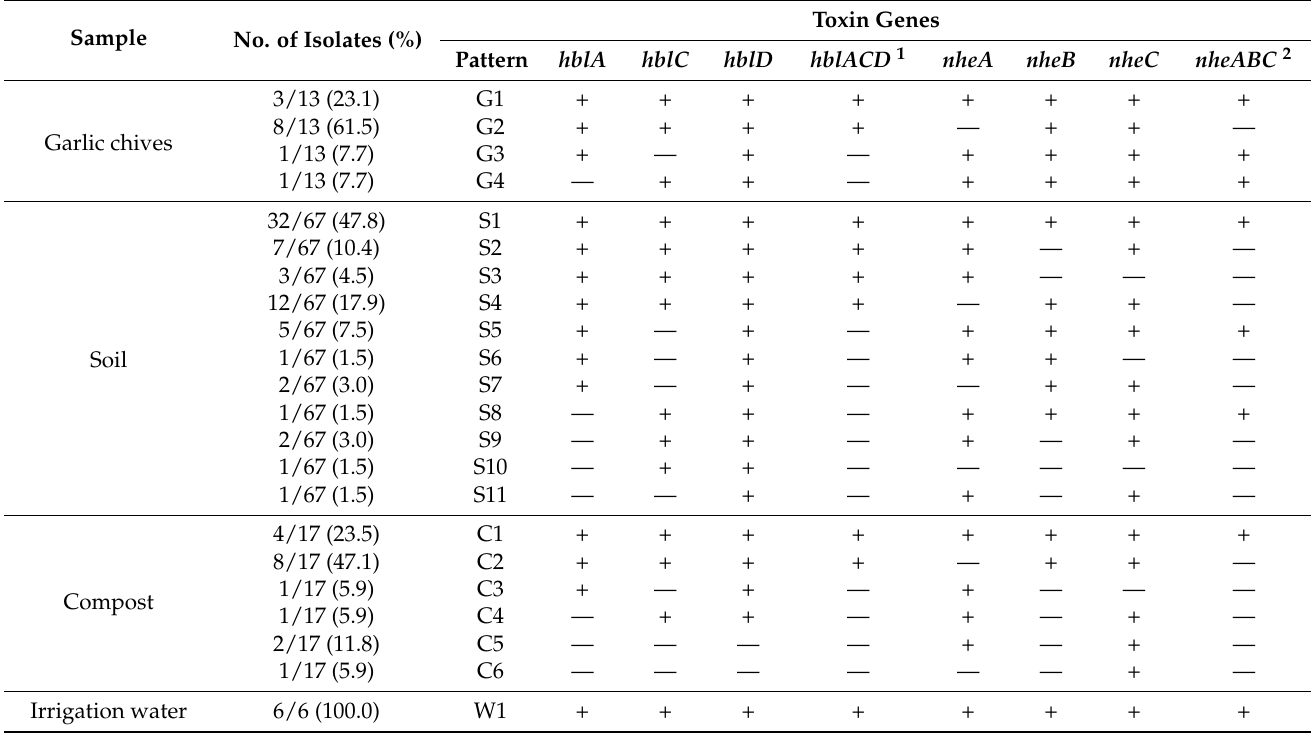
Table 1. B. cereus isolated from garlic chives and environment had diverse patterns of enterotoxin genes